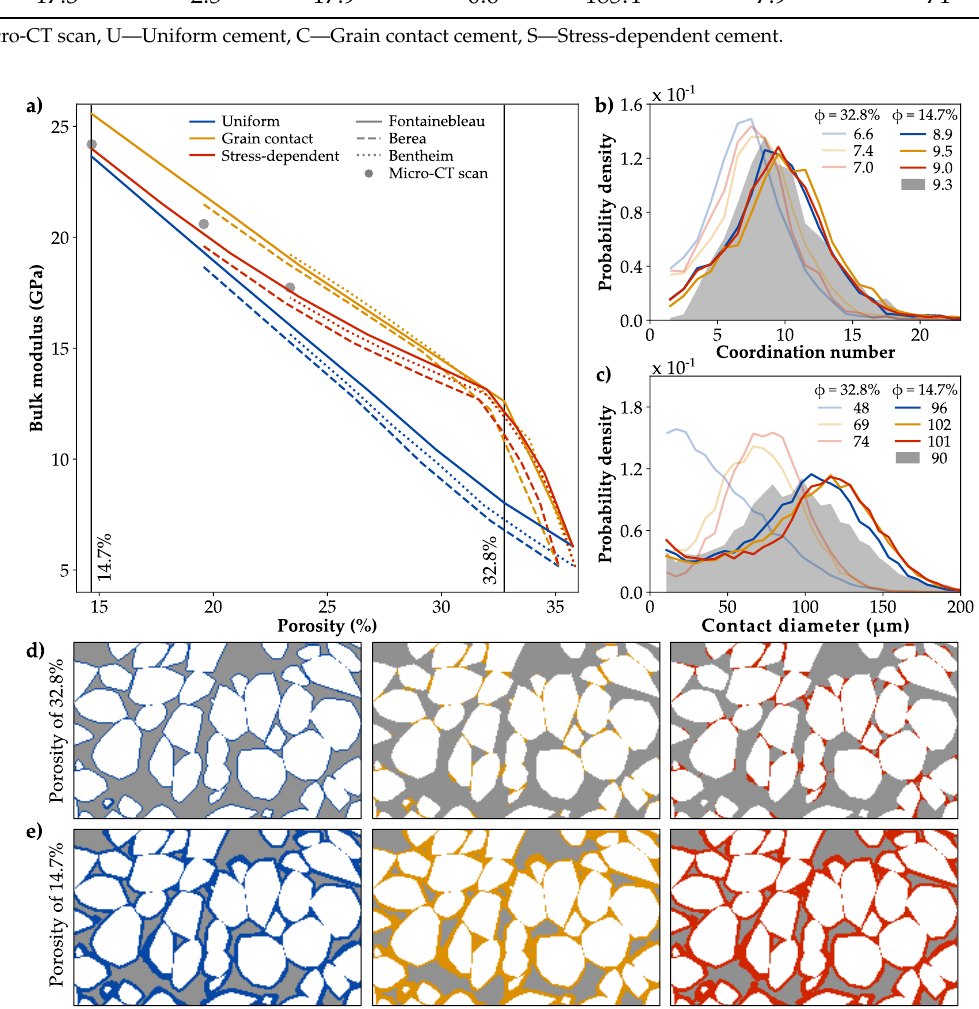
Figure 5. Evolution of mechanical and related granulometric properties for the micro-CT scans and the synthetic samples cemented by the uniform (blue), contact-preferential (orange) and stress- dependent scheme (red). ( a ) Diagenetic trends in bulk moduli for the three investigated sandstones. ( b ) Changes in coordination number and ( c ) grain contact diameter as well as ( d ) spatial cementation patterns at porosities of 32.8% and ( e ) 14.7% for the Fontainebleau